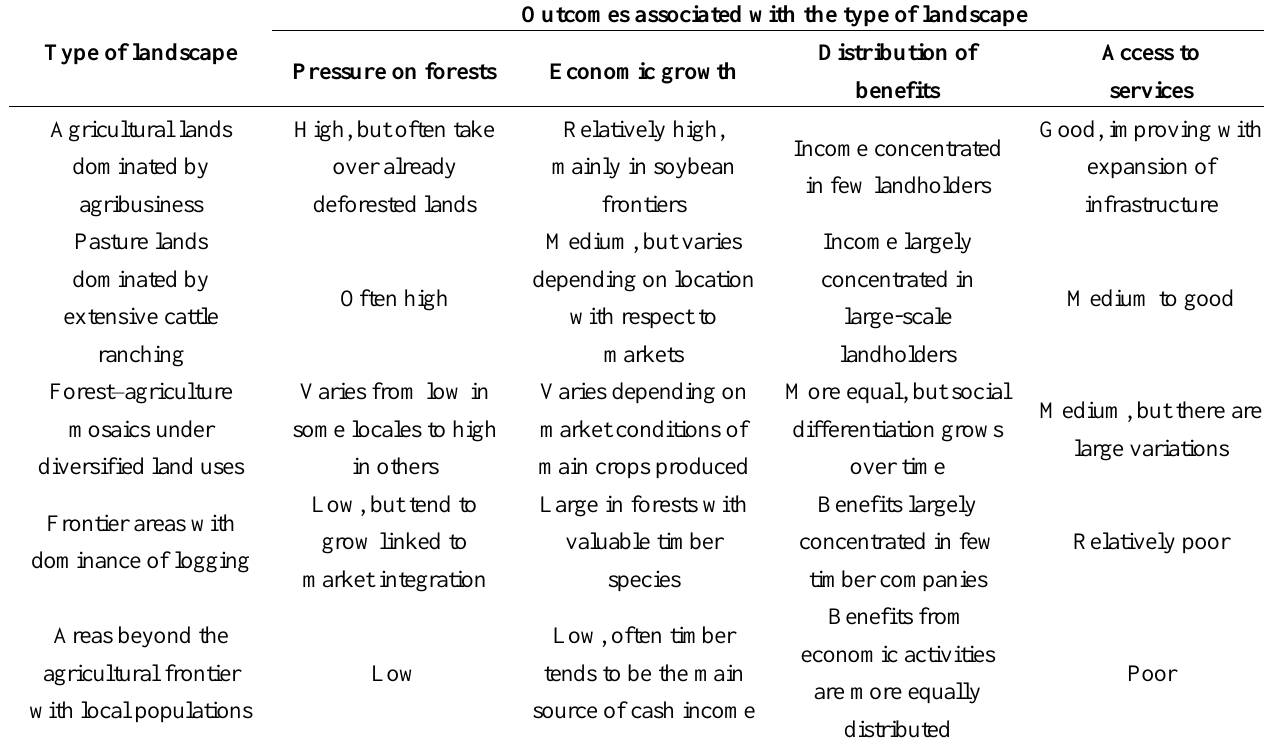
Table 6. Major outcomes from land use in the different landscape